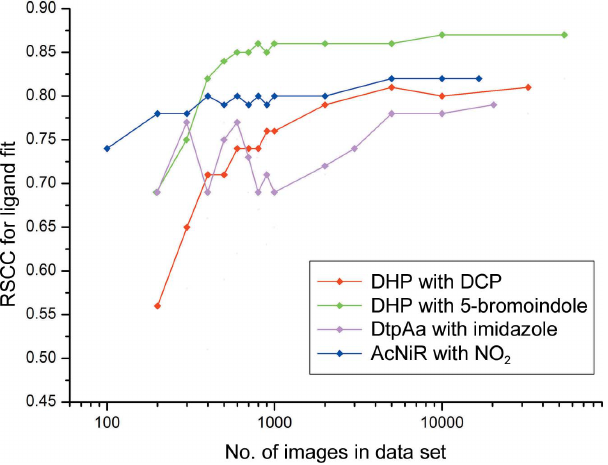
Figure 3 Real-space correlation coefficient (RSCC) values from EDIAscorer (Meyder et al. , 2017) as a function of the number of images per subset. Data are shown for the highest occupancy binding site for each complex. A plot including values for additional binding sites is shown in Supplementary Fig.